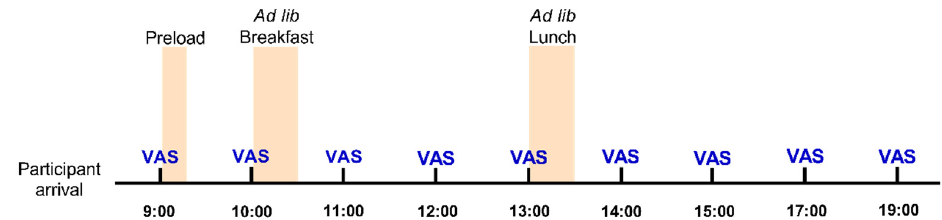
Figure 1. Timeline of the experimental design for each day of the study. VAS, visual analogue scale. The participants consumed the preload after completing the appetite